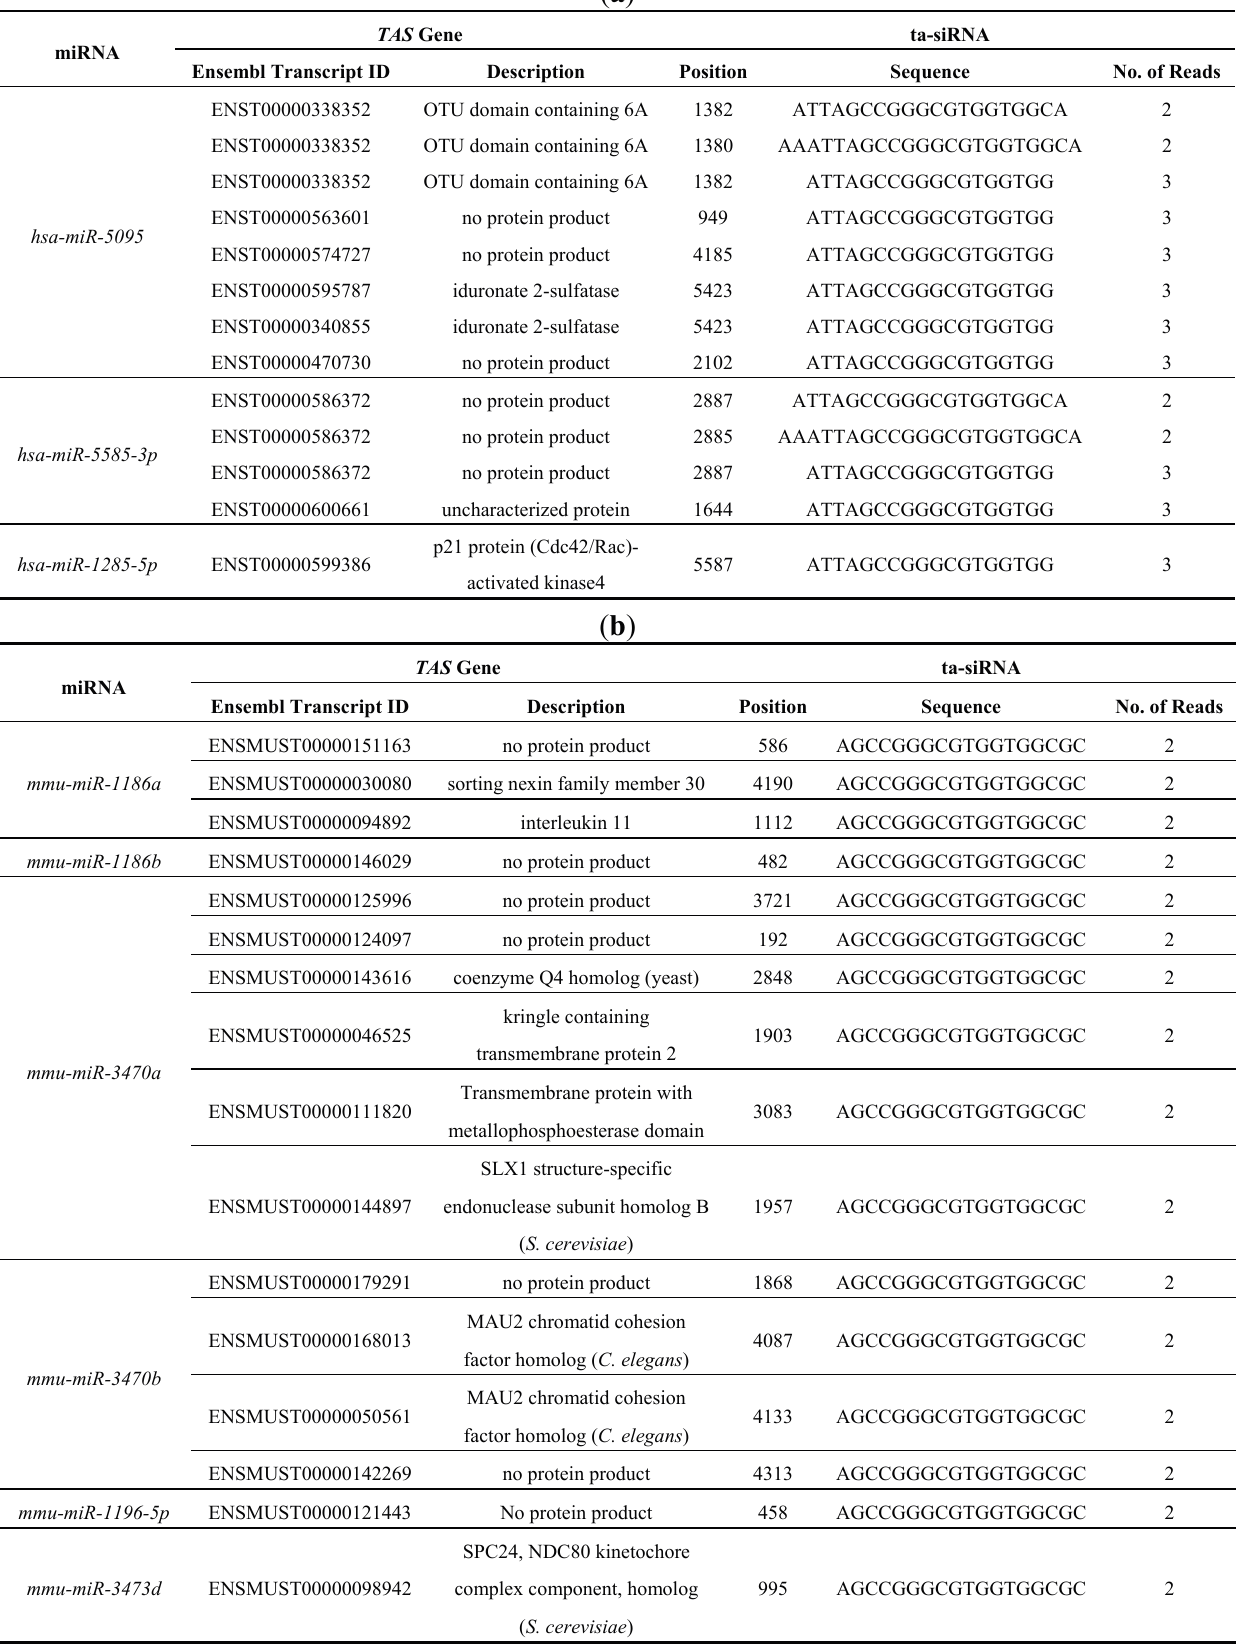
Table 3. ( a ) Similarities of ta-siRNAs in the human brain and mice; ( b ) Similarity of a mouse ta-siRNA with three human